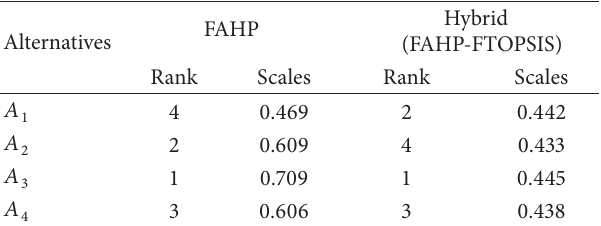
Table 10: The comparison of both FAHP-based and FAHP-TOPSIS hybrid